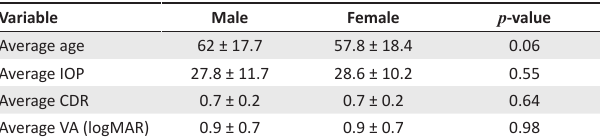
TABLE 4: Clinical characteristics of glaucoma by gender (right eyes only).